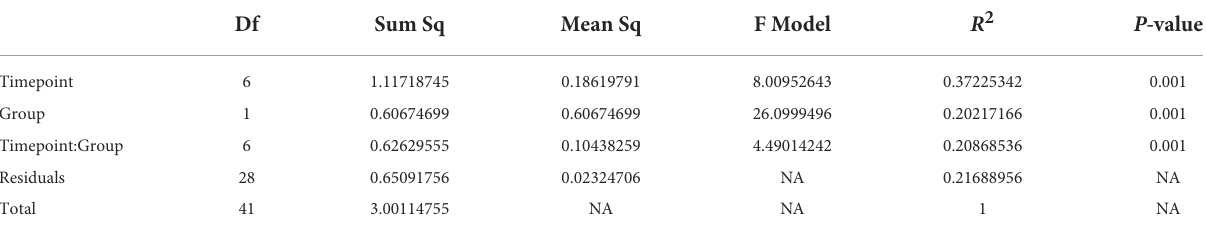
TABLE 1 PERMANOVA results based on Bray-Curtis distances using the abundance data for zebrafish gut microbiome. Df Sum Sq Mean Sq F Model R